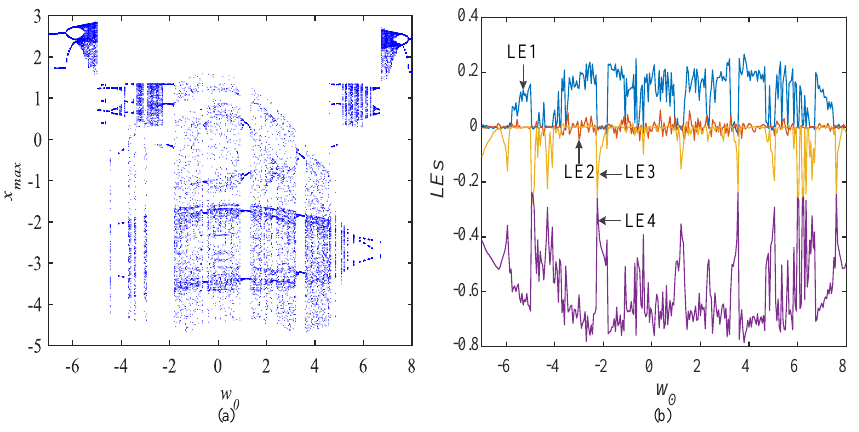
Figure 8. Dynamics with w 0 change: ( a ) bifurcation diagram; ( b ) Lyapunov exponents. Dynamical maps based on the SE complexity [41] and the maximum Lyapunove exponents in the y 0 − w 0 plane with a = 0.4, b = 2.6, c = 2.1, α = 1.8, β = 0.01 are shown in Figure 9. In Figure 9a, dark colors indicate a system is chaotic, and light colors indicate that the system may be periodic states, and white indicates divergence. The dynamic map based on the maximum Lyapunove exponent is more precise. Orange indicates the system is chaotic ( LEmax > 0.03), and yellow indicates stable resting behavior(0 < LEmax < 0.03), and cyan-blue indicates periodic states and blue indicates divergence. Dynamic map based on the maximum Lyapunov exponent can distinguish the state of the system at the critical region.